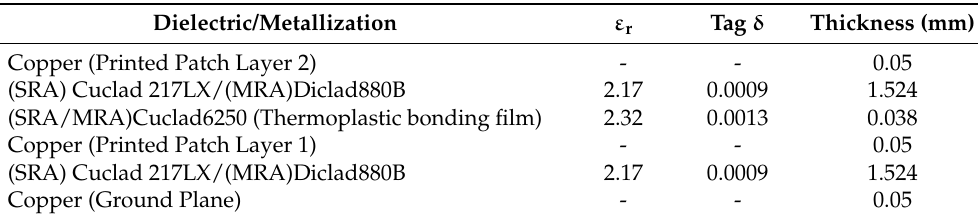
Table 2. Lay-up of the sandwich and radio-electric characteristics of the materials.